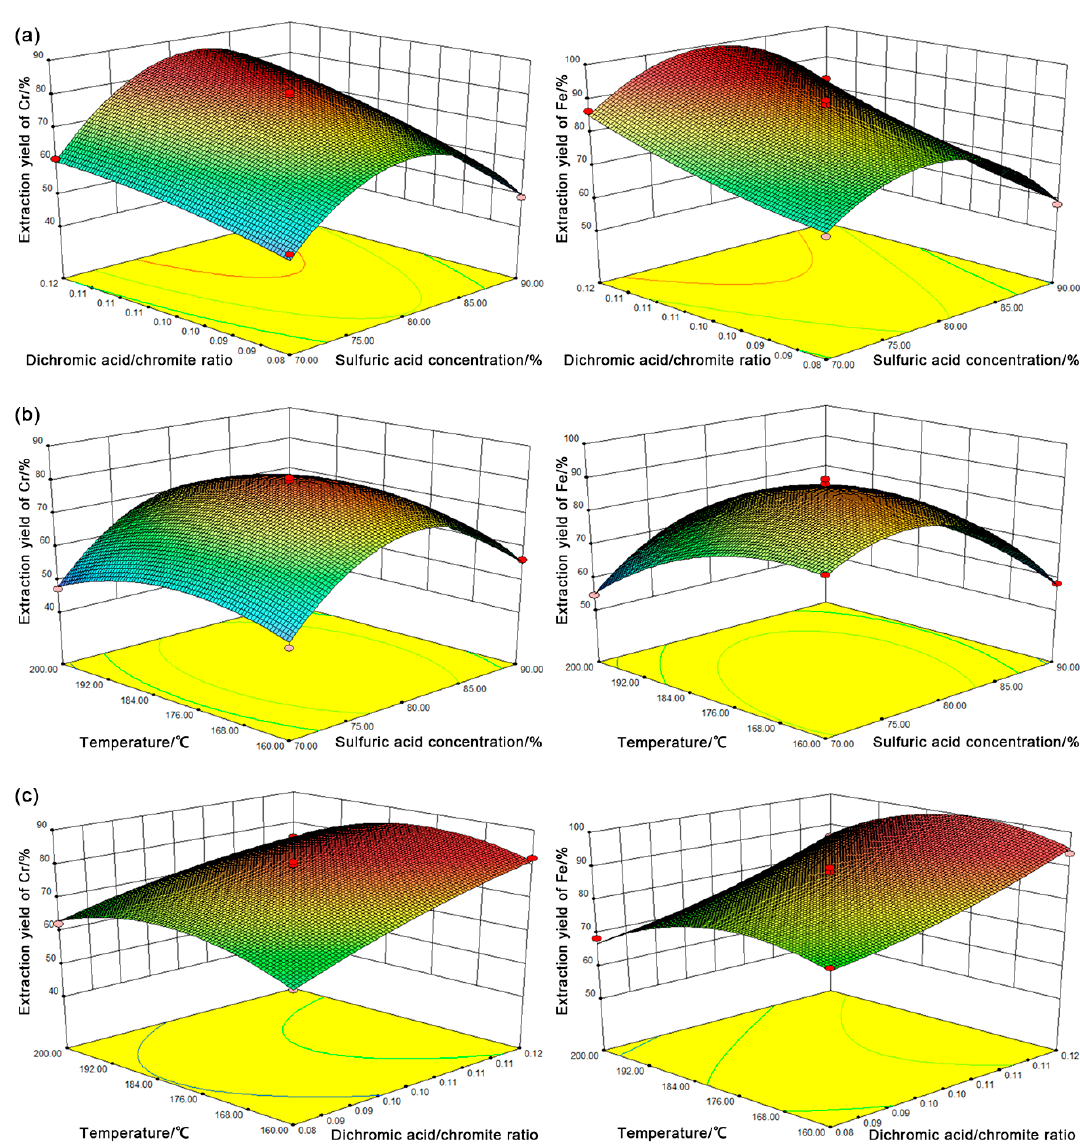
Figure 3. Three-dimensional response surfaces of extraction yield as a function of ( a ) sulfuric acid concentration and dichromic acid/chromite ratio at a temperature of 180 °C; ( b ) sulfuric acid concentration and temperature for a dichromic acid/chromite ratio of 0.10; ( c ) dichromic acid/chromite ratio and temperature for a sulfuric acid concentration of 80%.